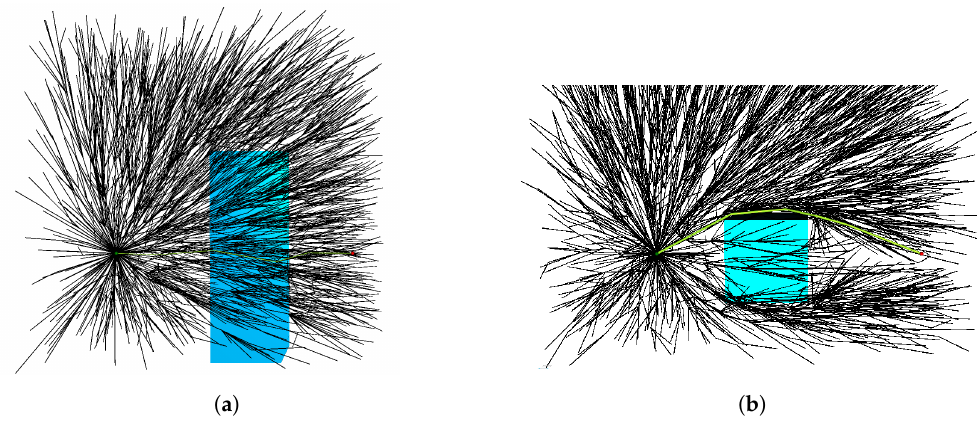
Figure 17. Example of the result of the FMT algorithm with one obstacle: number of samples = 3000, Figure 17. Example result of the FMT algorithm with one obstacle: Number of samples = 3000, computing time = 589.6 ms, error = 2%. The generated graph is drawn in black, the obstacle in blue, Computing time = 589.6ms, Error = 2%. The generated graph is drawn in black, the obstacle in blue and the path (start point in green and end point in red) in green. ( a ) Side view. The computed and the path (start point in green and end point in red) in green. trajectory passes behind the obstacle; ( b ) top view.